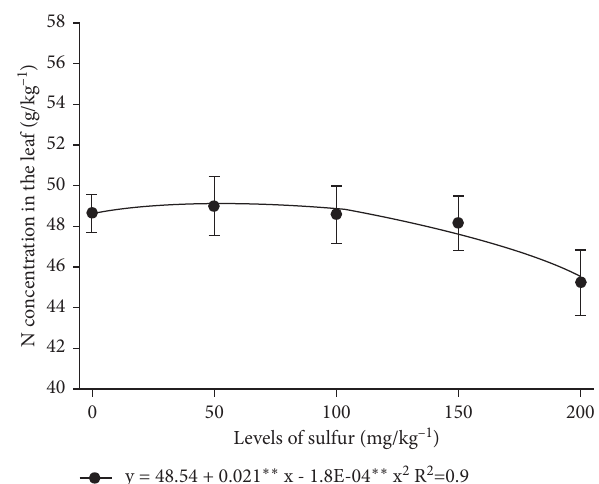
Figure 1: Effects on soybean leaf nitrogen content in response to different sulfur levels. Note. Nitrogen content in the leaf of soybean tends to decrease in concentration at different levels of sulfur nutrients applied to the plant. The figure is adapted from [38].